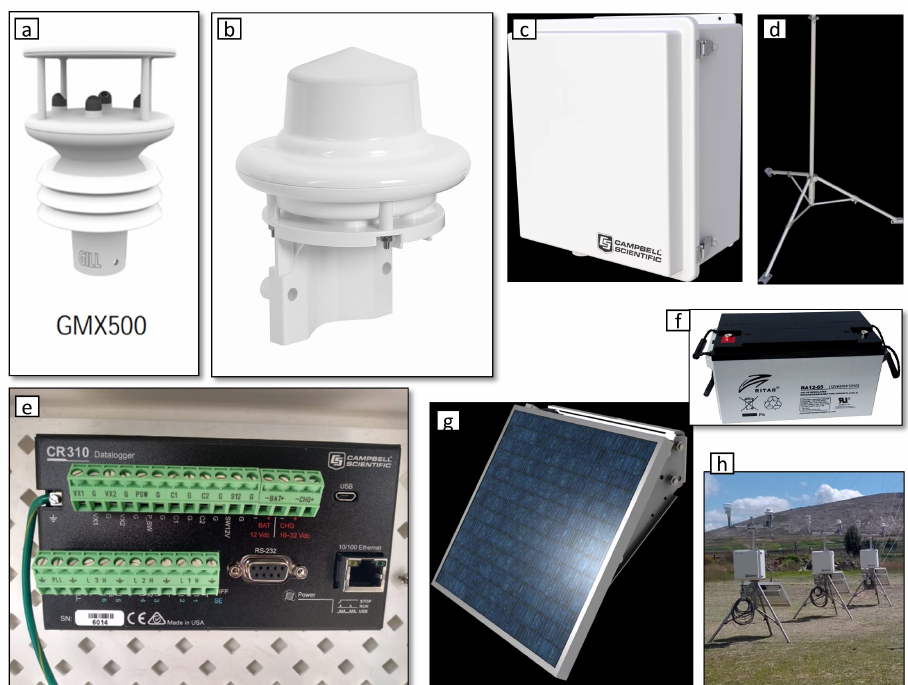
Figure 2. Components of the automatic compact stations. ( a ) Weather Sensor GMX500 MAXIMET GILL series. ( b ) WS100 Lufft Precipitation Sensor. ( c ) Campbell Scientific Box. ( d ) Stainless steel tripod. ( e ) Datalogger CR310—CAMPBELL SCIENTIFIC. ( f ) Battery Ritar 12 v 65 Ah AGM. ( g ) SP30 solar panel. ( h ) Final assembled